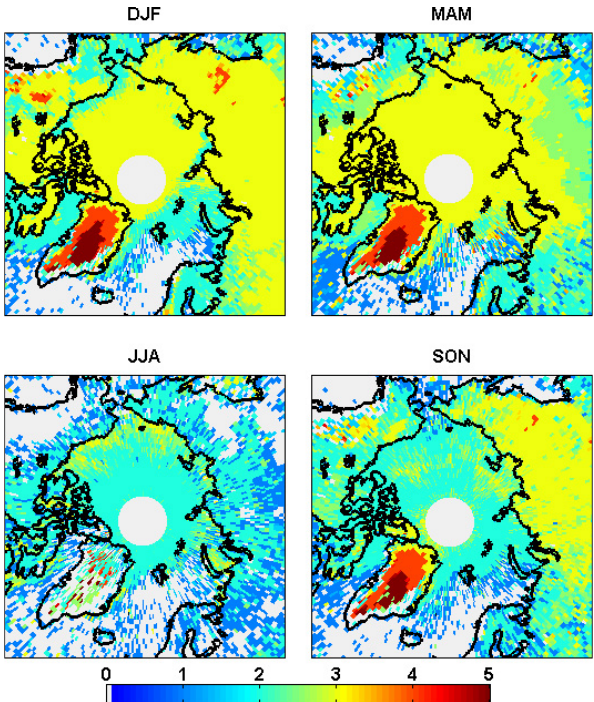
Fig. 5. Median pressure level at which peak in WV inversion was observed. 1–1000hPa, 2–925hPa, 3–850hPa, 4–700hPa, 5– 600hPa and above.